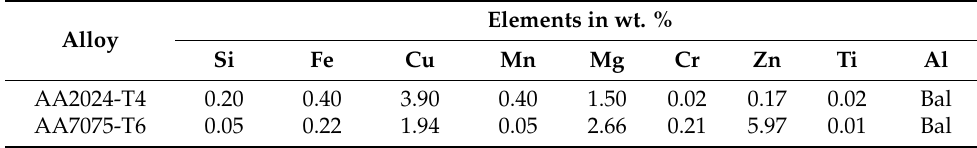
Table 1. Chemical analysis (wt. %) of the AA2024-T4 and AA7075-T6 alloys.